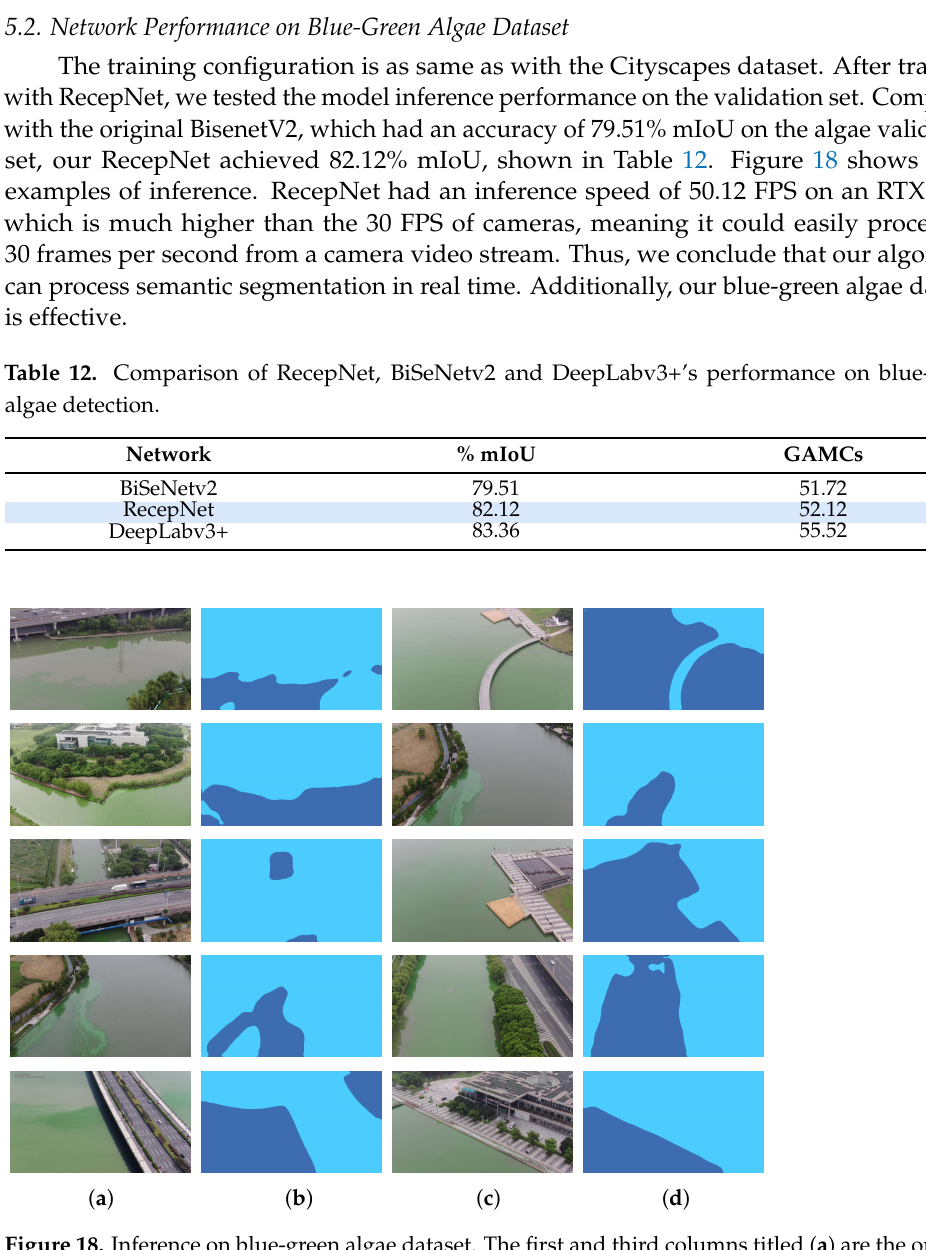
Figure 18. Inference on blue-green algae dataset. The first and third columns titled ( a ) are the original images; the second and fourth columns titled ( b ) are labels, where the dark blue part is the identified blue-green algae area; ( c ), raw images; ( d ), inference